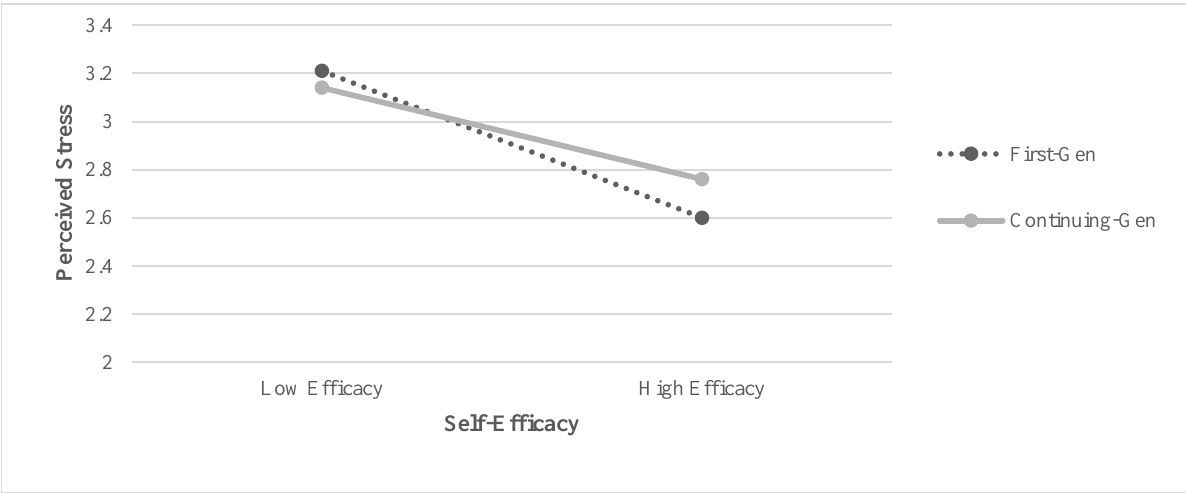
Figure 2. Gender moderated self-efficacy and perceived stress.